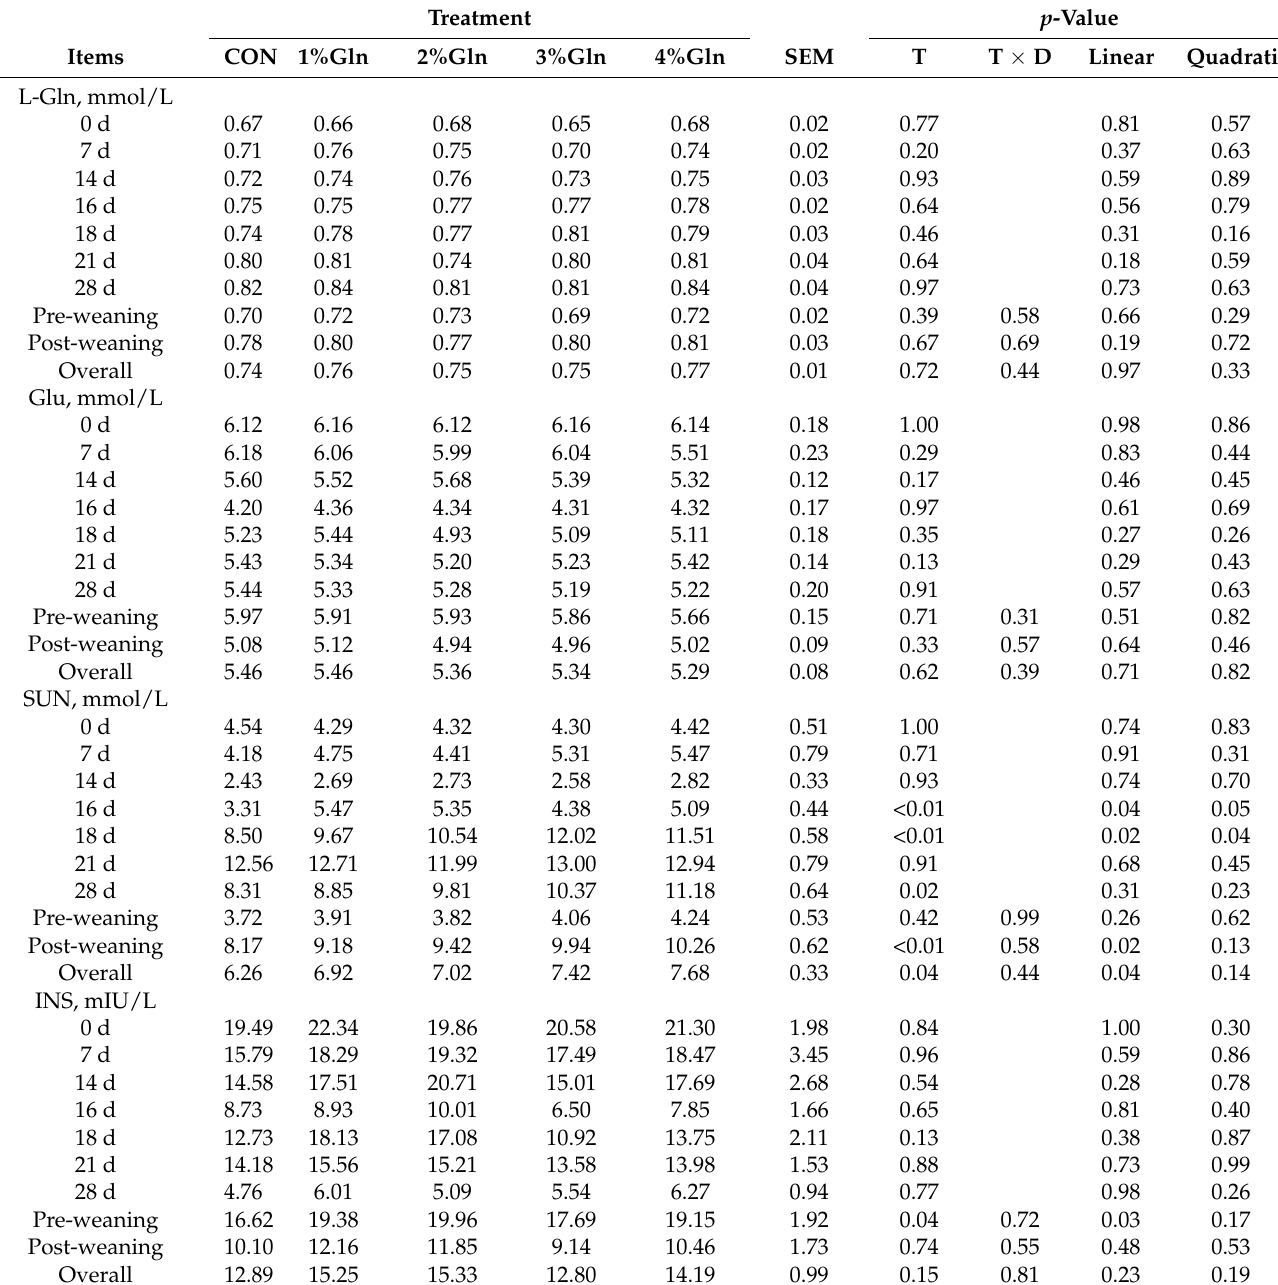
Table 2. Serum Gln, Glu, BUN, and INS indicators of calves among different groups (N = 9 per group). Treatment p